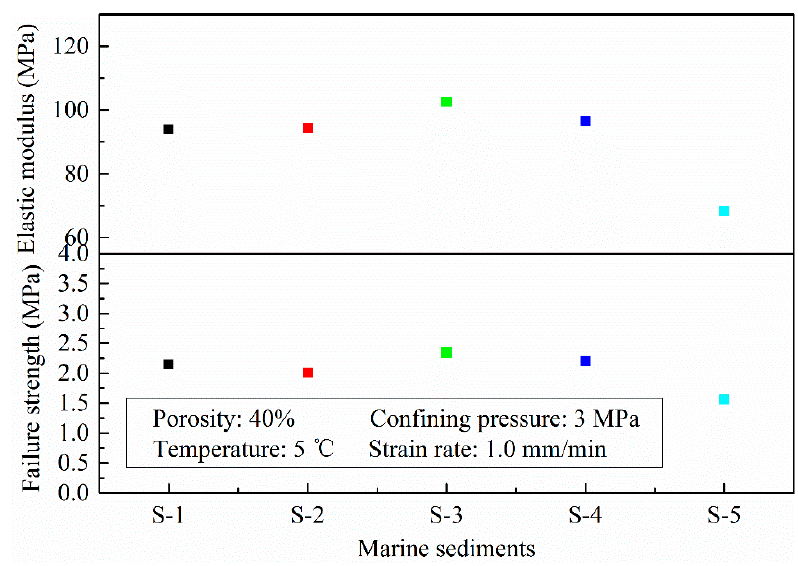
Figure 6. Elastic modulus and failure strength of HBMS at different drilling depths.